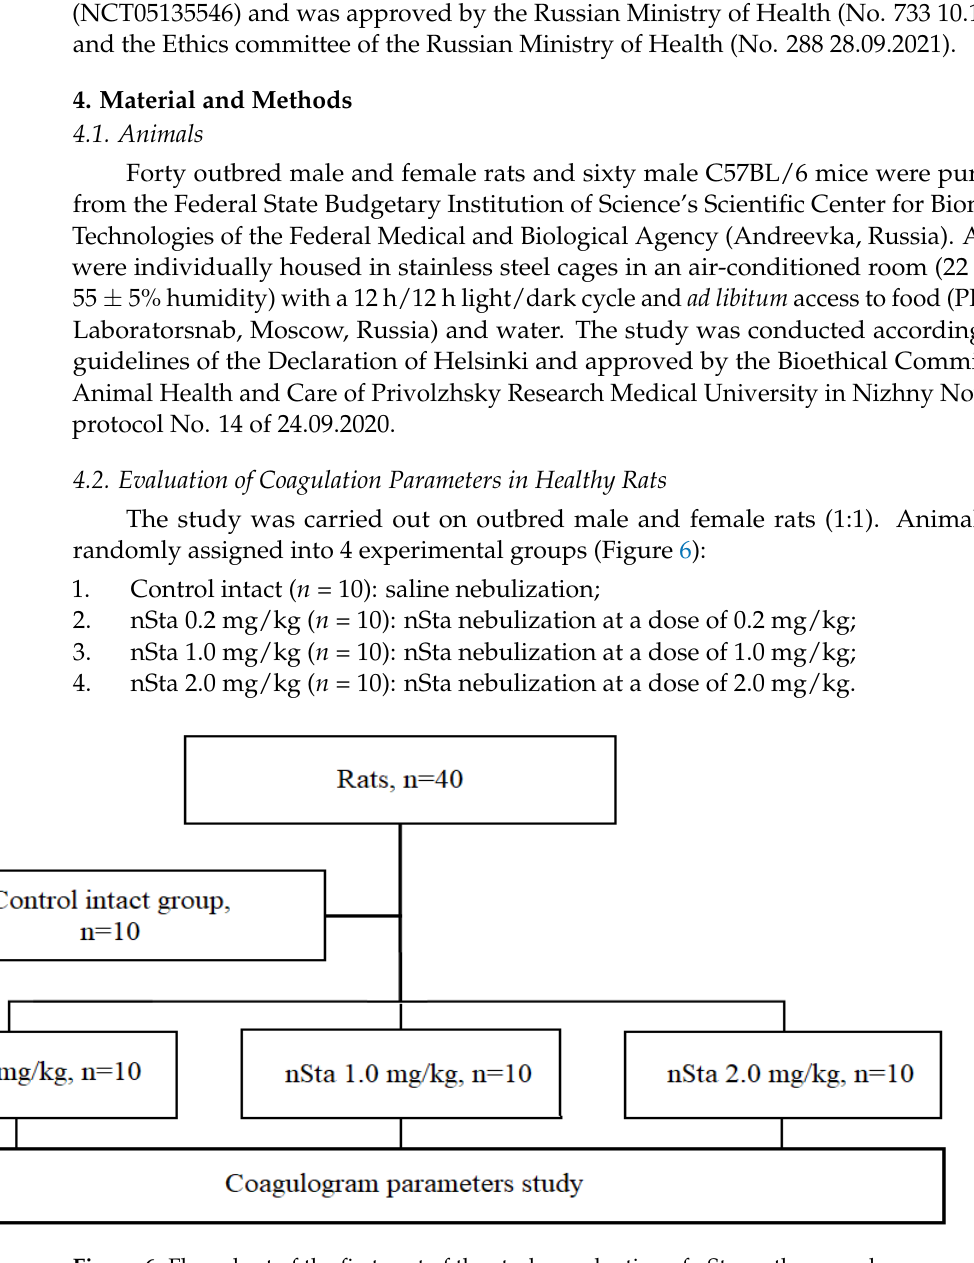
Figure 6. Flow chart of the first part of the study: evaluation of nSta on the coagulogram parameters in healthy rats.